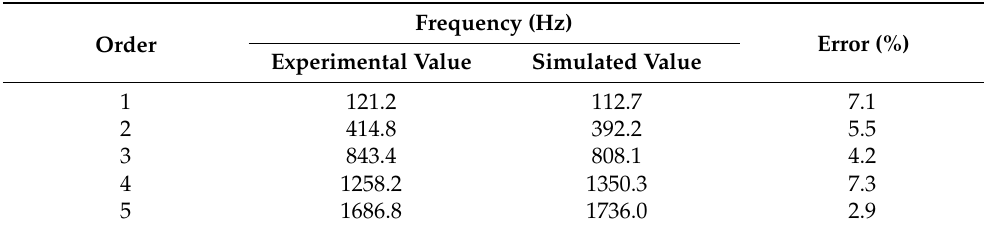
Table 4. Comparison of experimental and simulated values of the frequencies of the TBM main drive system.